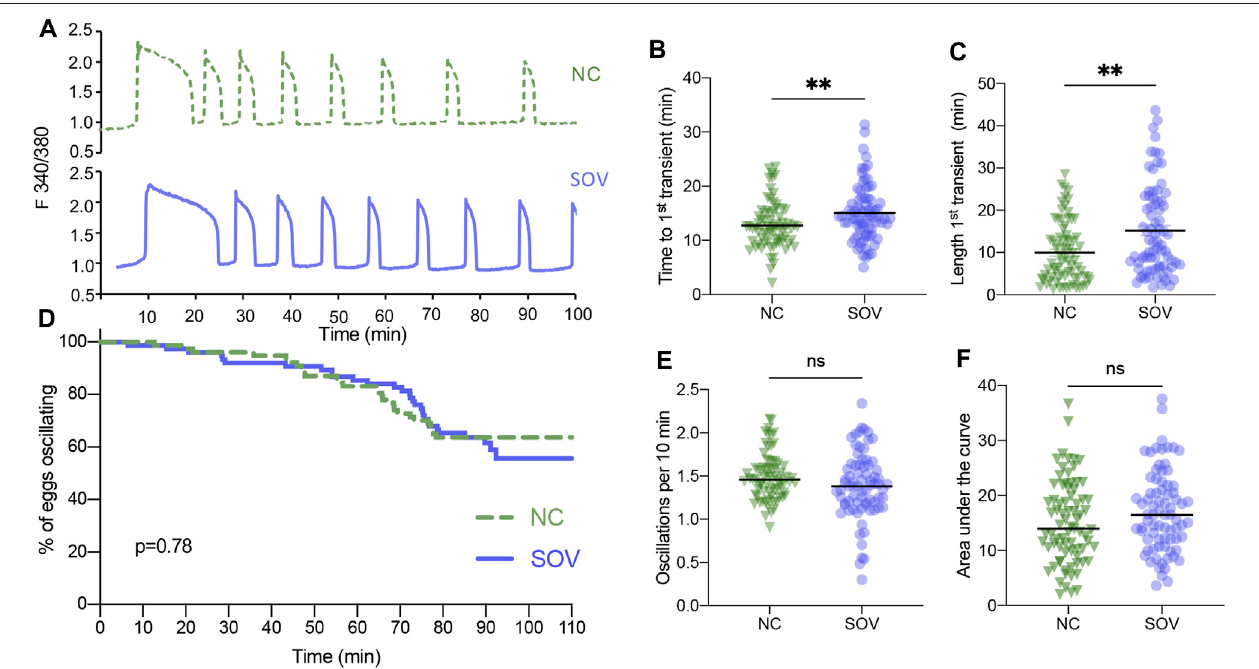
FIGURE 1 | Calcium oscillatory patterns following strontium-induced parthenogenetic activation of MII eggs from naturally cycling (NC) and superovulated (SOV) mice. (A) Representative calcium traces. (B) Time to the fi rst transient. (C) Length ofthe fi rst calcium transient. (D) Percentage ofeggs that continued to display calcium oscillations during 110 min. p -value indicated on graph. (E) Oscillation frequency averaged over the fi rst 60 min ofoscillations. (F) Area under the curve of calcium signal during the fi rst 60 min following activation. Graphs in (B,C,E,F) show median and all individual data points. ** p < 0.01; ns, no signi fi cant difference.